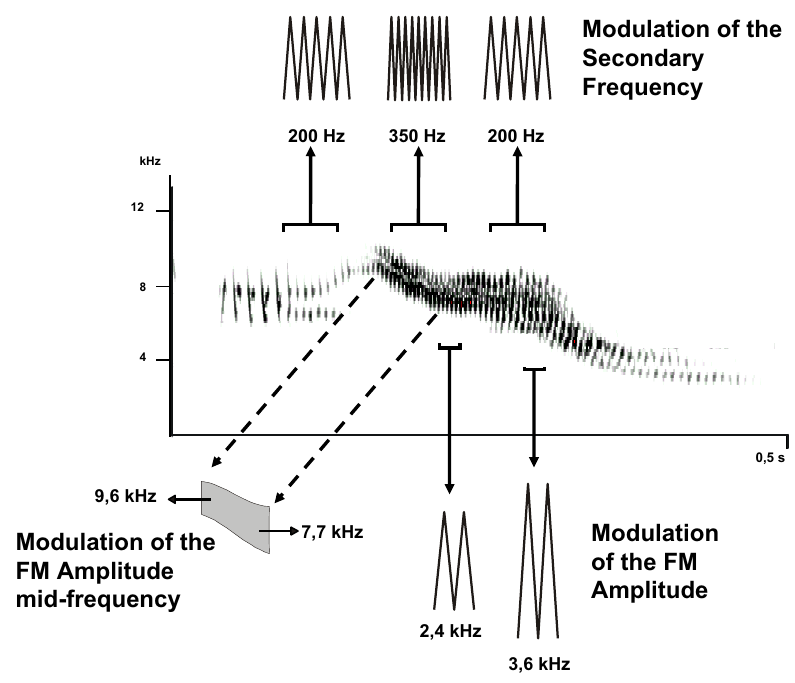
Fig. 6 – Example of modulations of the Vibrations, with its structural